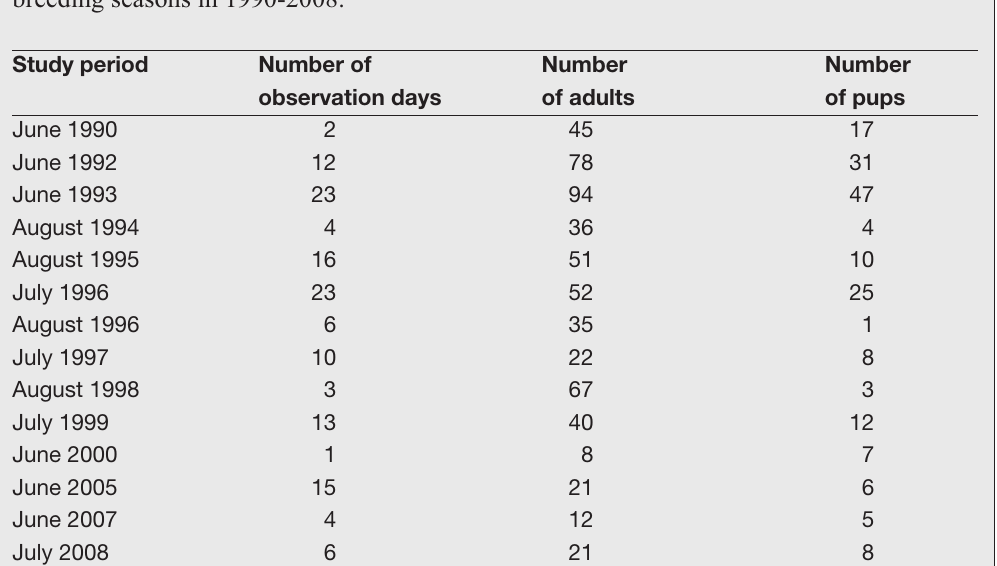
Table 2. Maximum numbers of harbour seals counted in the Ivanovskaya Bay during the breeding seasons in